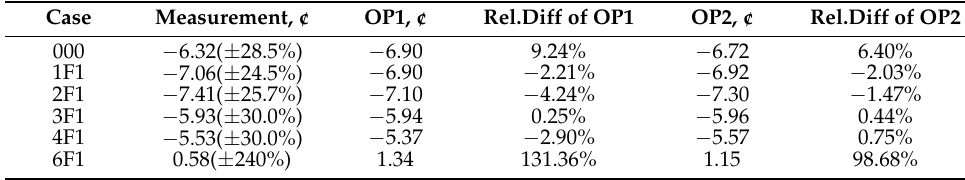
Table 3. Results and comparison of SVR value of JOYO